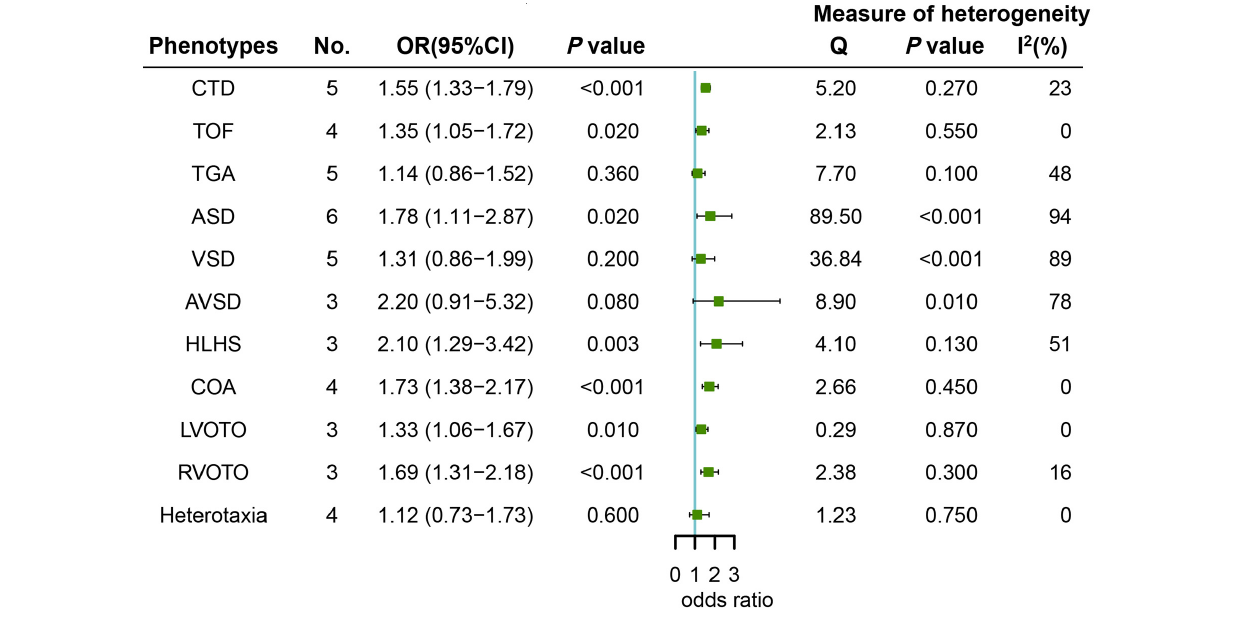
FIGURE 3 | Forest plot of maternal HDP exposure and risk of most CHD phenotypes in